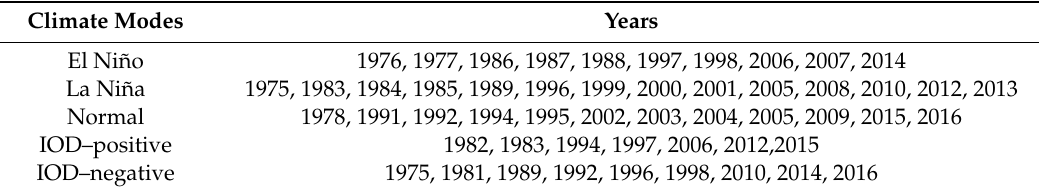
Table 1. Identified years under various climate modes during